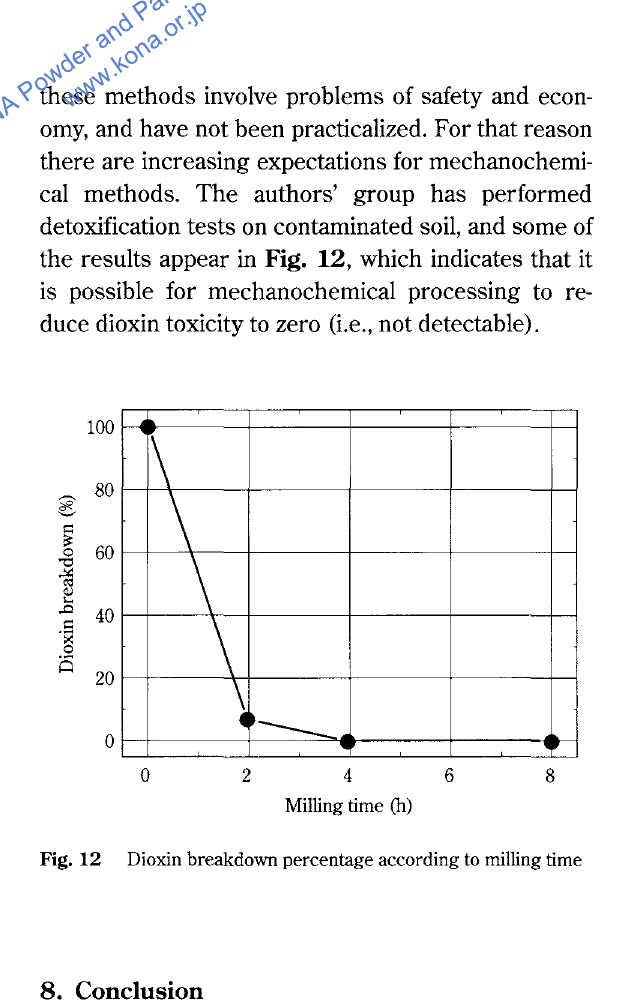
Dioxin breakdown percentage according to milling